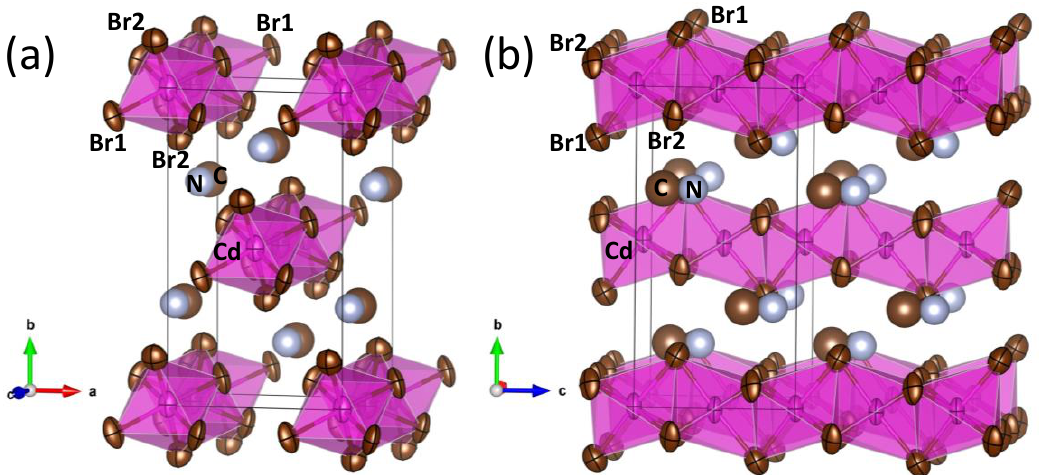
Figure 3. Two views of the crystal structure, showing the anisotropic atomic displacement parameters (ADP) of Br site and the face-sharing octahedral chains along c axis. ( a ) along c-axis direction, ( b ) along a-axis direction.